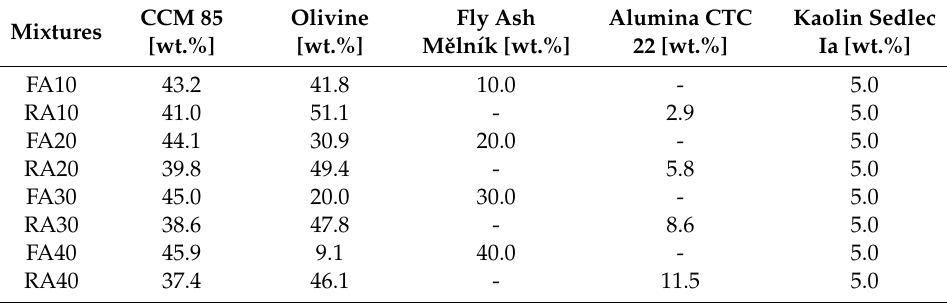
Table 2. Designed compositions of all raw material